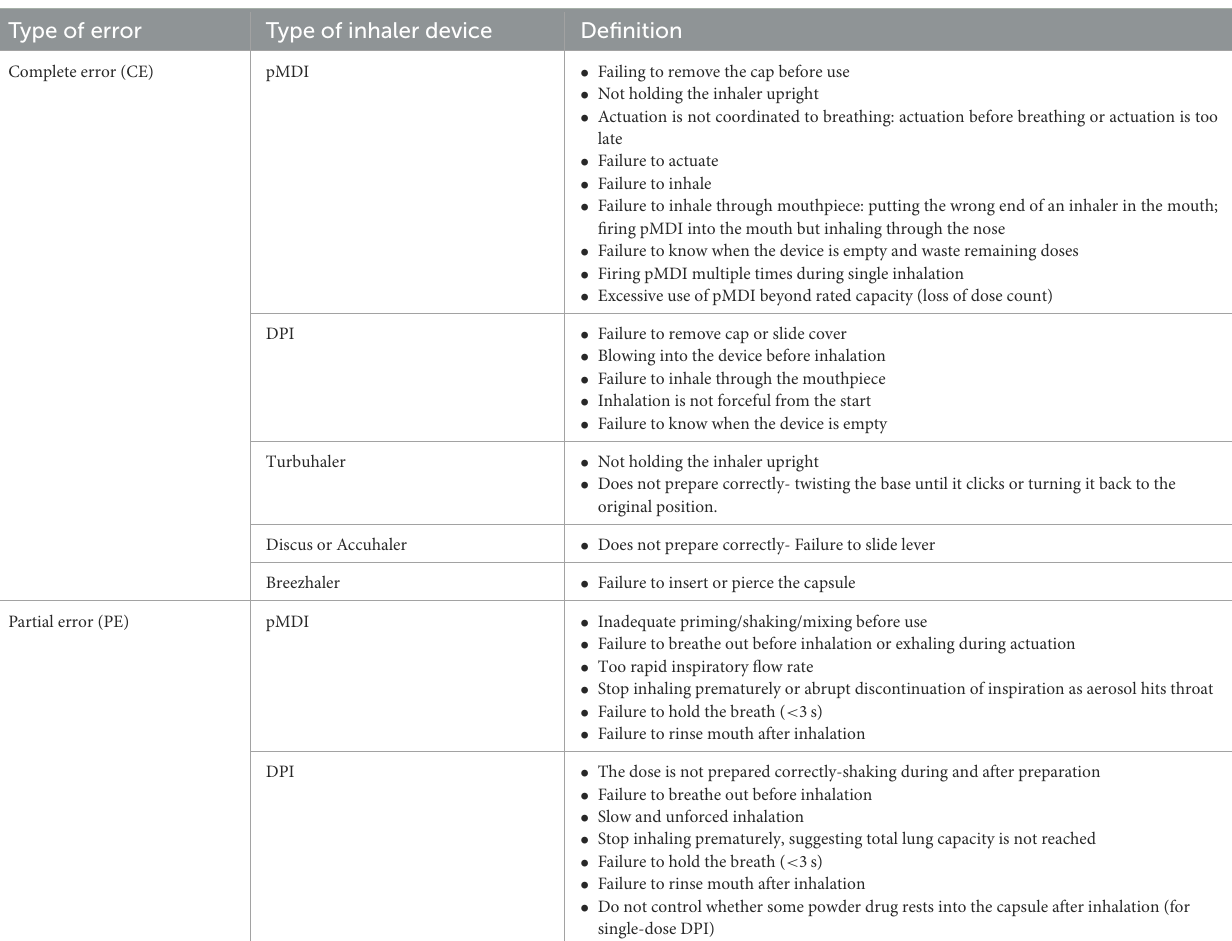
TABLE 1 Definitions for operating errors of inhalers in standardized training